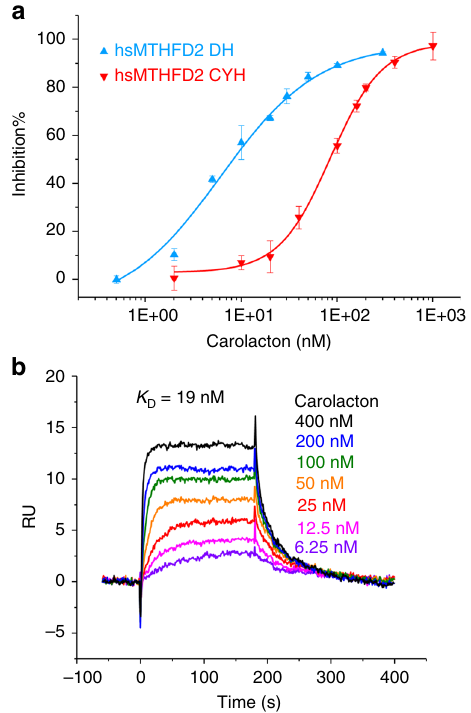
Fig. 4 Carolacton effects on the human enzyme hsMTHFD2. a IC 50 determination for carolacton against DH and CYH activity of hsMTHFD2. Data are presented as means ± s.e.m. of three independent replicates. IC 50 s were obtained via logistic dose – response fi tting. The one-way ANOVA test was used for statistical analysis, P < 0.01. b SPR analysis of carolacton binding to hsMTHFD2. Carolacton shows strong binding to hsMTHFD2. The estimated K D was obtained by fi tting the association and dissociation signals with a 1:1 interacton model using the Biacore X 100 Evaluation Software